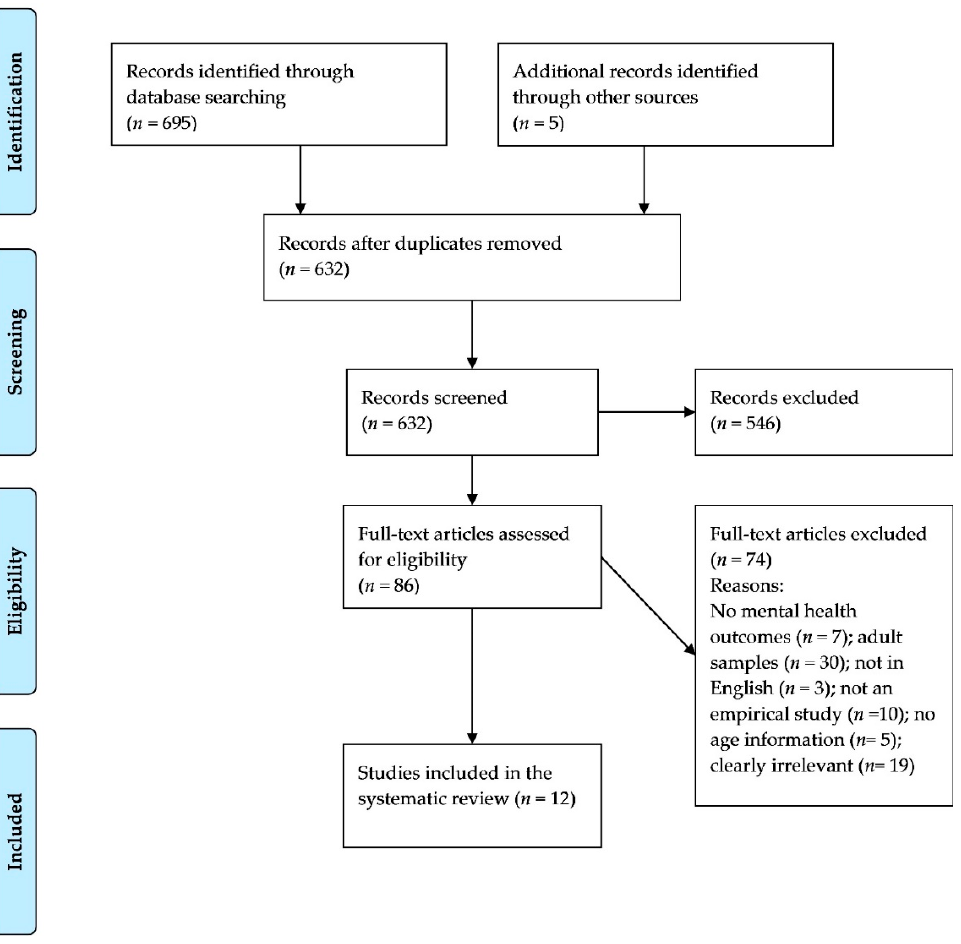
Figure 1. PRISMA 2009 flow diagram.